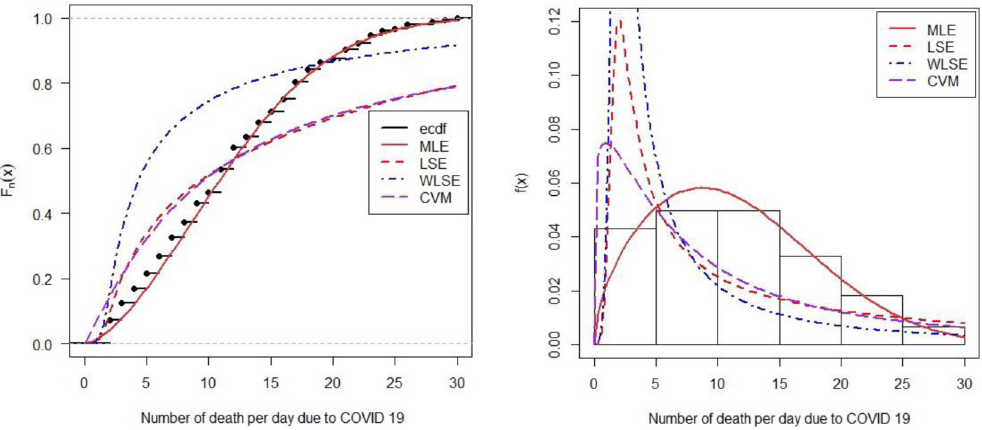
Fig 3. Plot the empirical distribution function with estimated CDF (left panel), histogram with estimated PDF (right